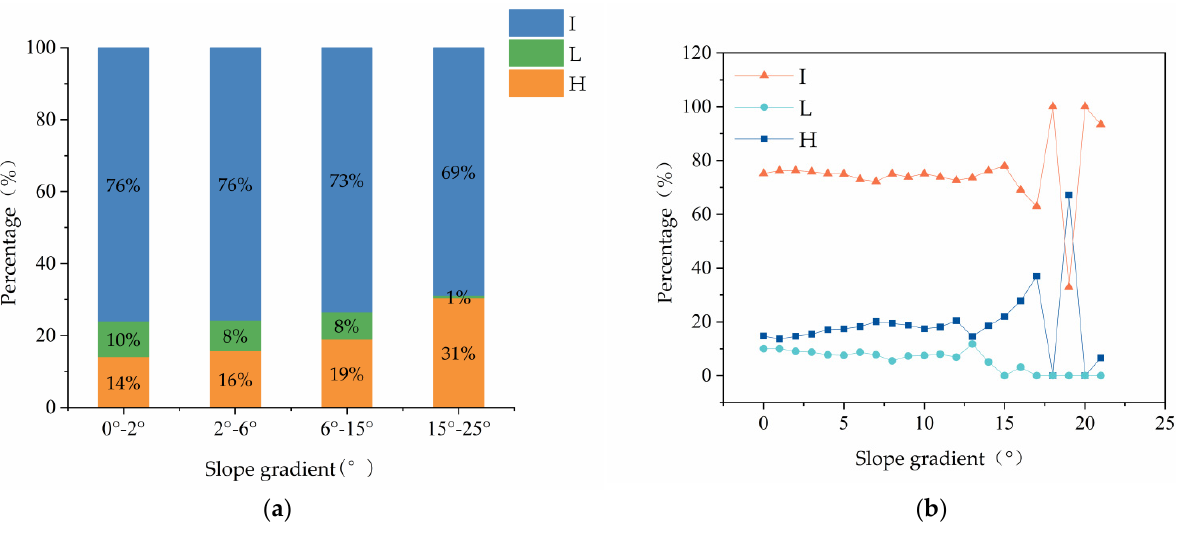
Figure 4. ( a ) Area-proportion map of cultivated land with all ridge orientations with respect to different slope gradients. ( b ) Area-proportion line chart of slope gradient and different ridge orientations of cultivated land, where: I, inclined ridge; L, longitudinal ridge; and H, horizontal ridge.